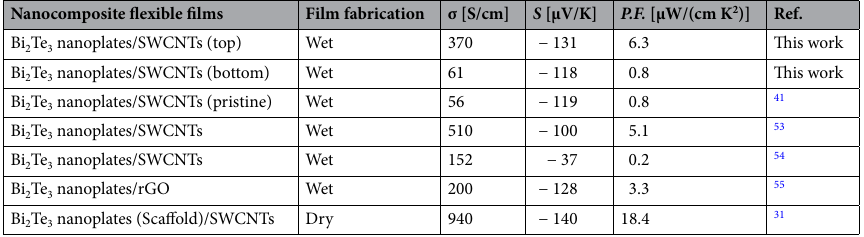
Table 1. Thermoelectric properties of nanocomposite flexible